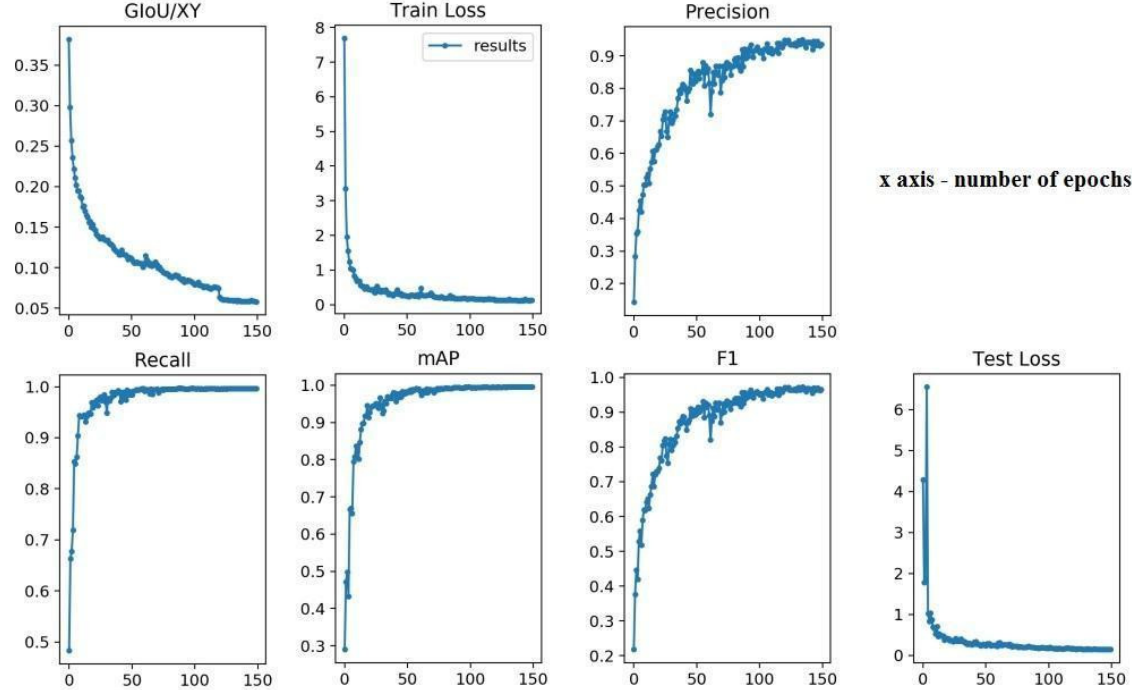
Figure 9. Graphical representation of the results for training 9. Table 4. Summarized results for effects of other applied augmentation